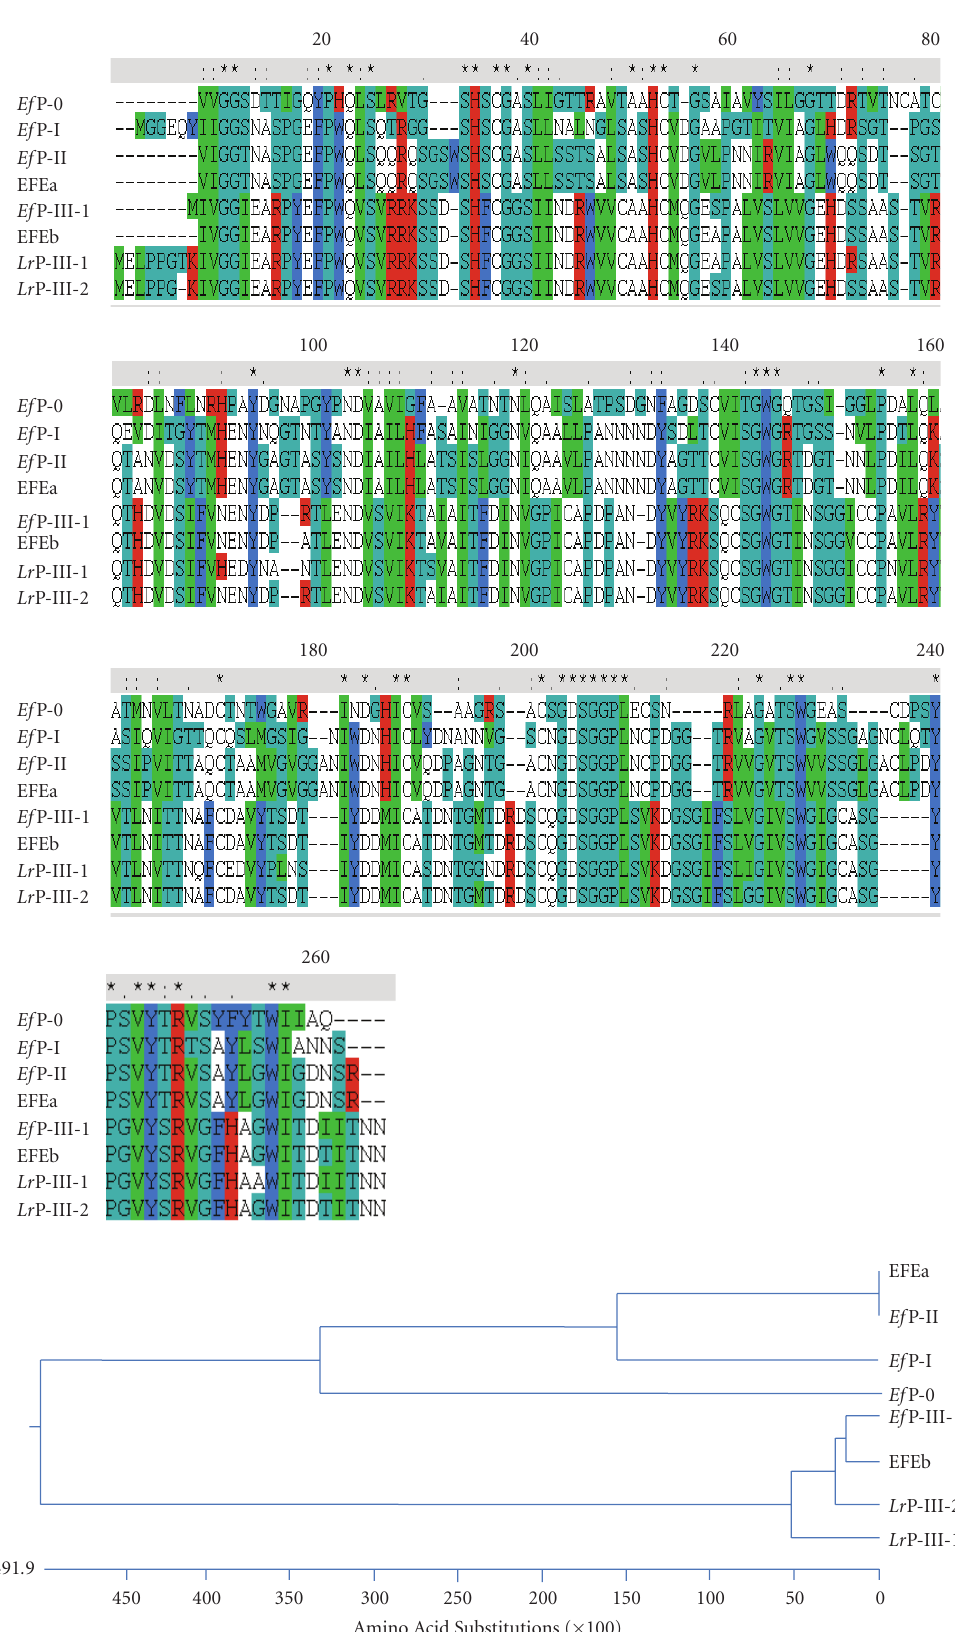
Figure 3: Multiple sequence alignment of some earthworm proteases. The amino acid sequences were from GenBank and PDB (see